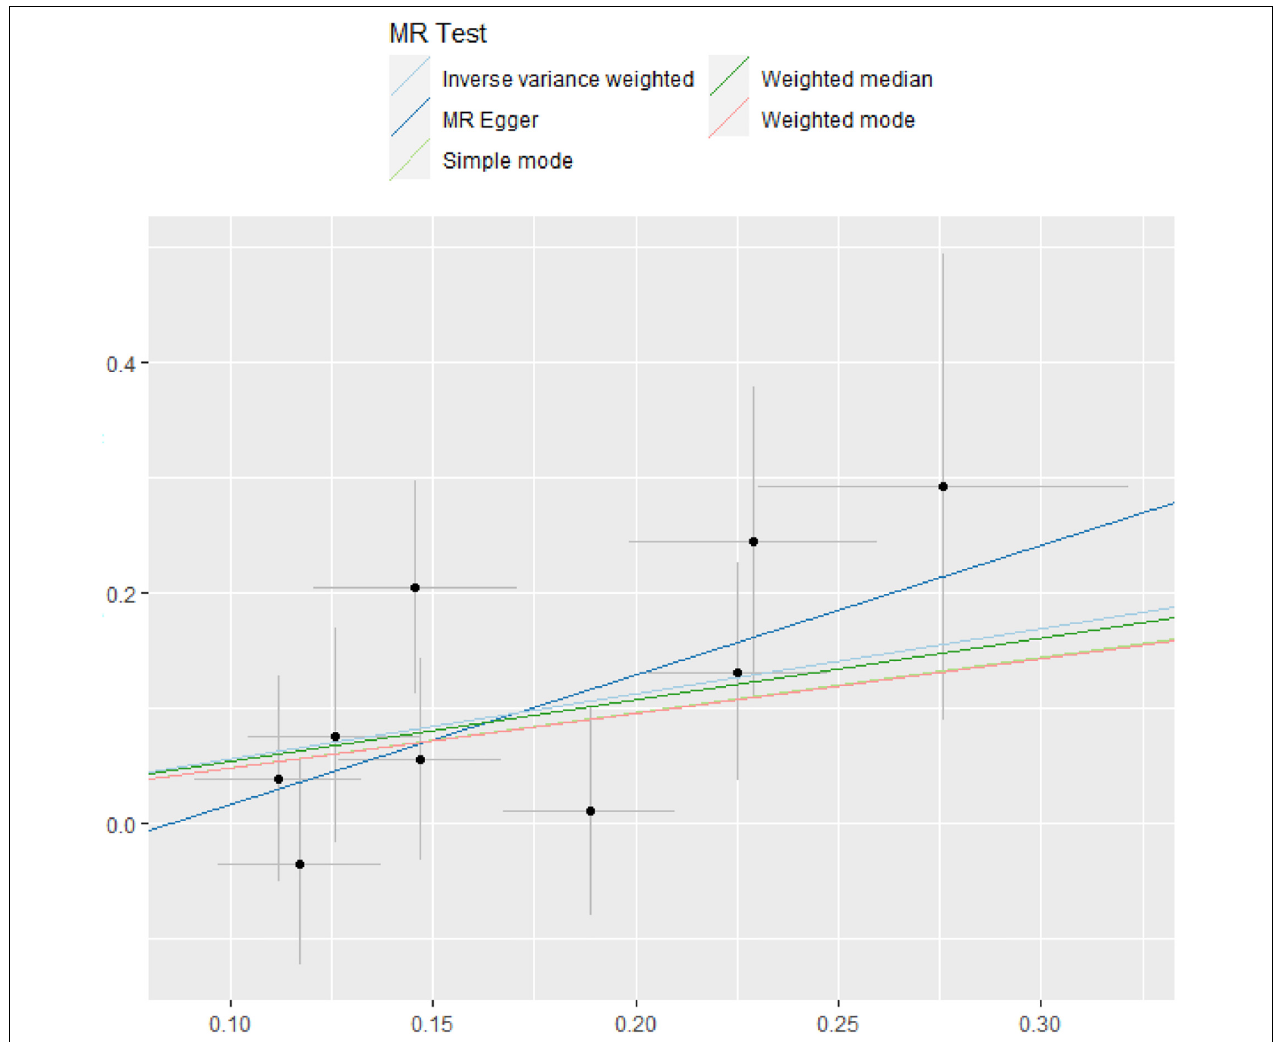
FIGURE 3 | MR test. The estimate of intercept can be interpreted as an estimate of the average pleiotropy of all SNPs, and the slope coefficient provides an estimate of the bias of the causal effect. MR, Mendelian randomization; SNP, single-nucleotide